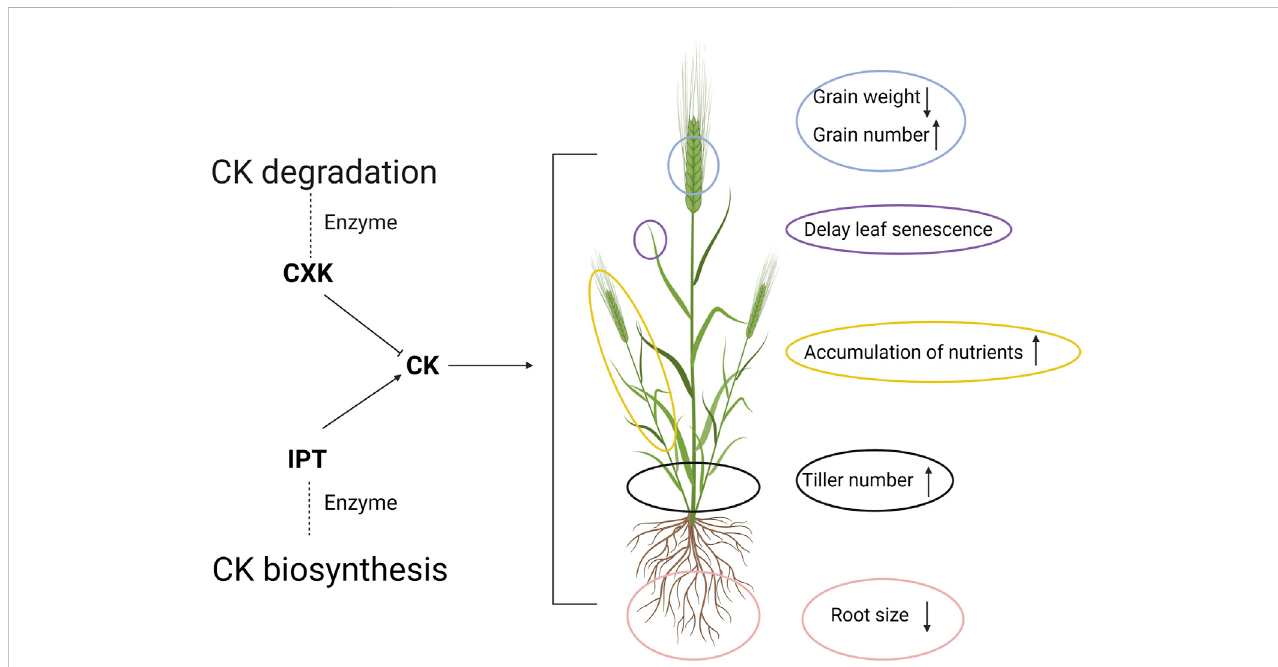
FIGURE 2 The regulatory role of cytokinin (CK) in the barley plant. The degradation and biosynthesis of CK is majorly controlled by two enzymes, CK oxidase and phosphate-isopentenyl transferase (IPT). The increase in CK level will lead to a series changes of above-ground plant performance associated with N metabolism. The upwards arrows and downwards arrows indicate the increase and decrease in the corresponding traits, respectively. Created with